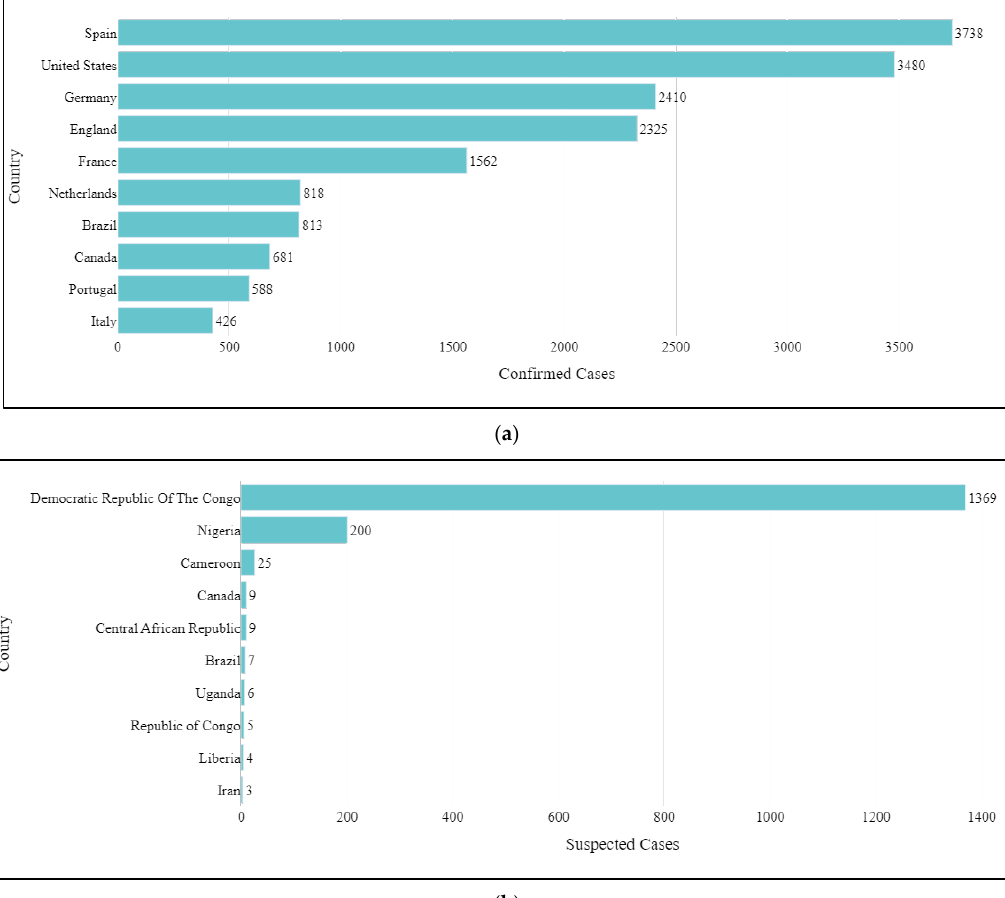
Figure 6. Top 10 countries according to the ( a ) confirmed cases, ( b ) suspected cases, and ( c ) hospi- talized cases.